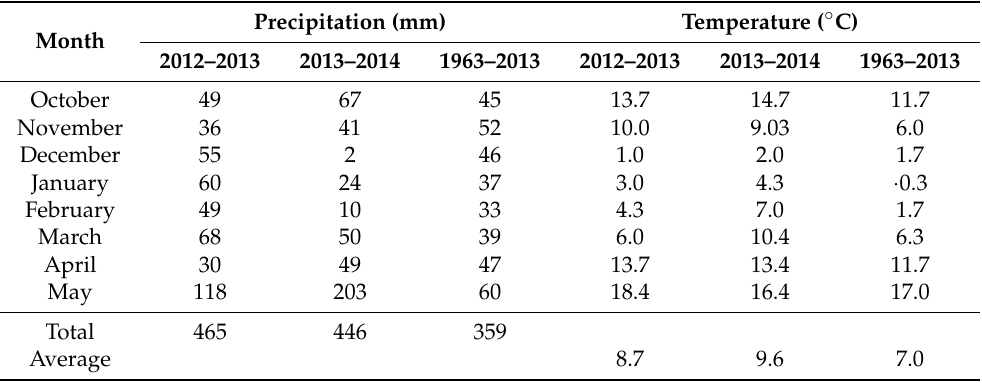
Table 2. Precipitation and mean monthly temperature for growing season (2012–2014) and long-term average (1963–2013) at the experiment